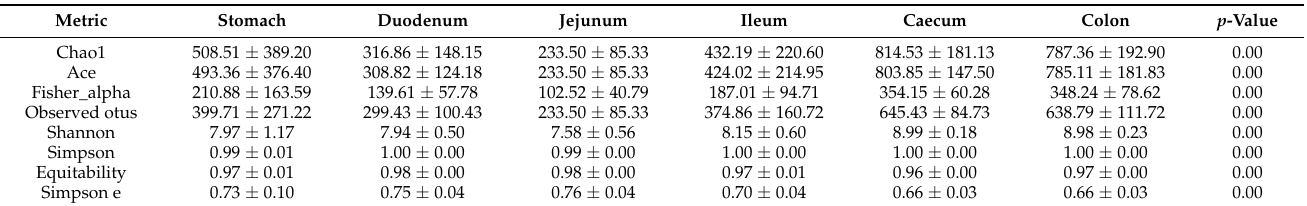
Table 2. Significance of the difference in alpha diversity indexes between regions of the rabbit’s gastrointestinal tract. Benchmark is the caecum microbiota alpha diversity. Values are means ± standard deviations.